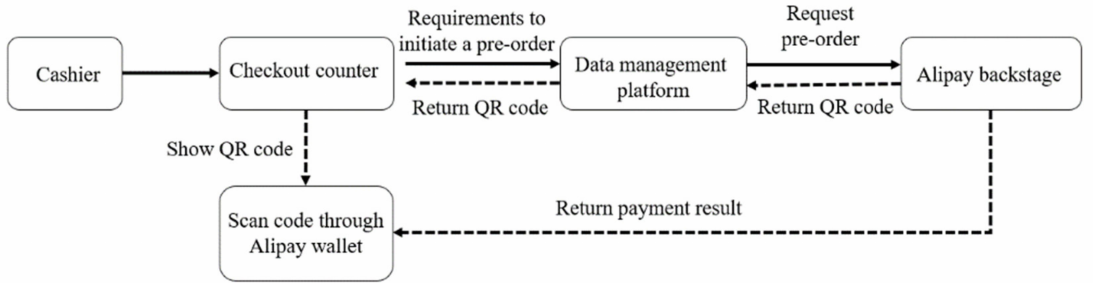
Figure 13. The flow chart of the electronic payment